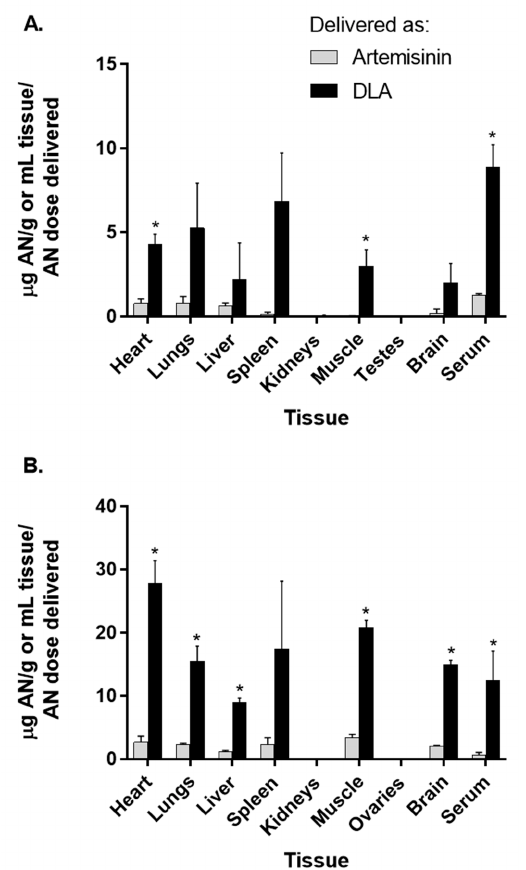
Figure 2. Artemisinin distribution in tissues and serum of male ( A ) and female ( B ) rats after oral delivery of artemisinin as dried leaf A. annua (DLA) or pure artemisinin. n = 3, *; p ≤ 0.05; error bars = SEM. While artemisinin distributed well to most tissues, it cleared by 8 h. Neither artemisinin nor deoxyartemisinin was detectable in any tissues or serum 8 h postgavage. Serum was also collected at 2 and 4 h postgavage; however, neither artemisinin nor deoxyartemisinin was detectable in either gender. In male rats, heart, liver, and muscle had a significant difference in deoxyartemisinin distribution between DLA and pure artemisinin-treatments (Figure 3A). In female rats, however, there was a significant difference in deoxyartemisinin distribution to heart, lungs, spleen, muscle, brain, and serum (Figure 3B). DLA contains a small amount of deoxyartemisinin (7.5 mg/kg dose), so deoxyartemisinin detected in animals treated with DLA is likely not all from liver metabolism. Animals given pure artemisinin, however, did not receive any deoxyartemisinin, so any deoxyartemisinin detected in their tissues was due solely to artemisinin liver metabolism.